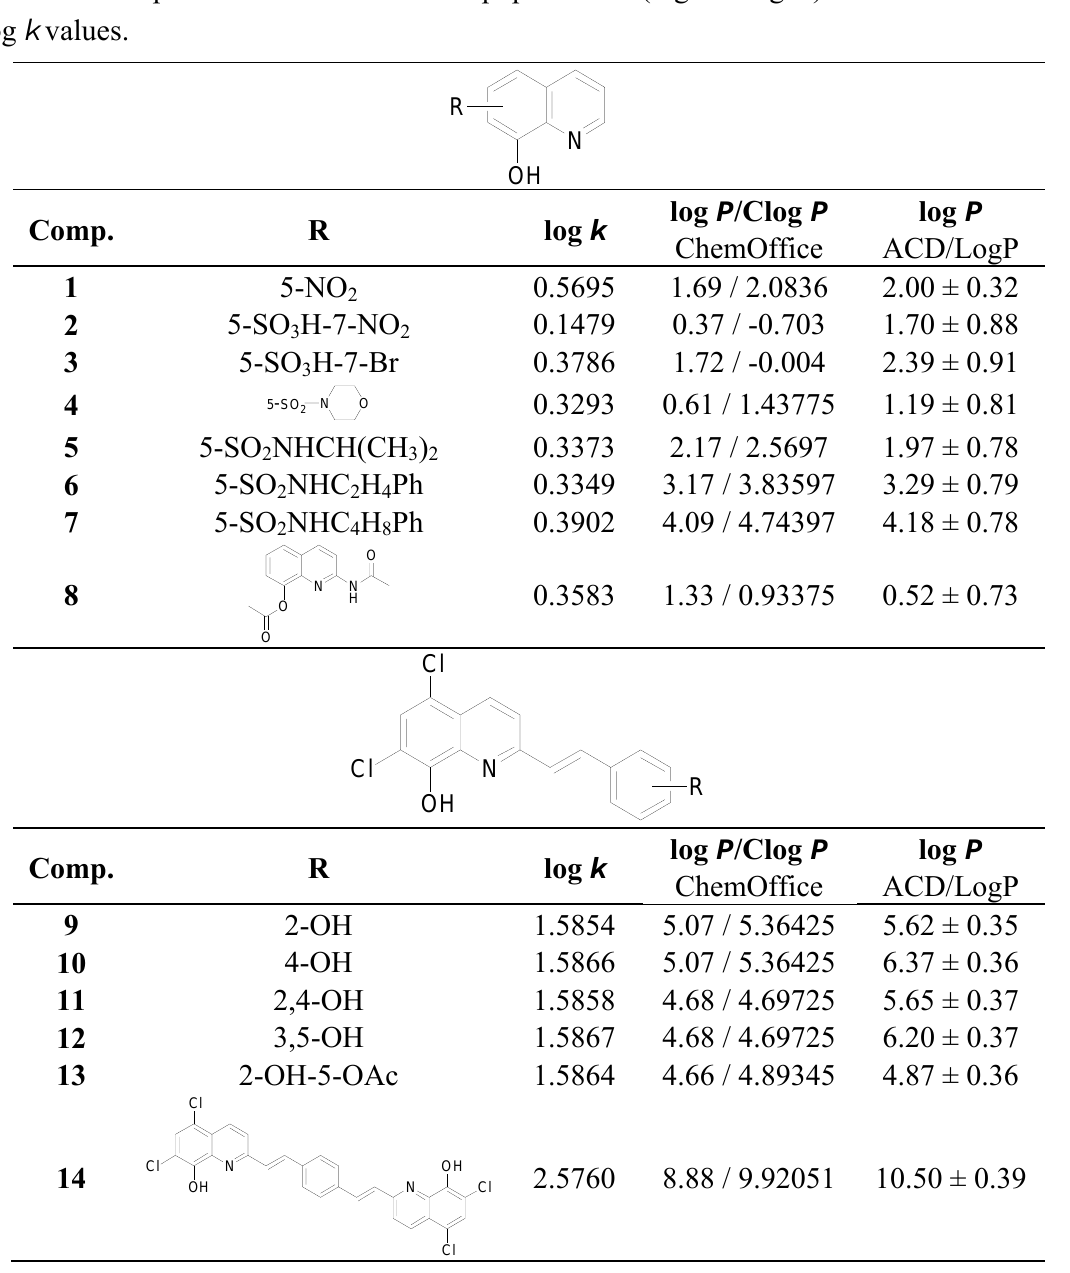
Table 1. Comparison of the calculated lipophilicities (log P /Clog P ) with the determined log k values.